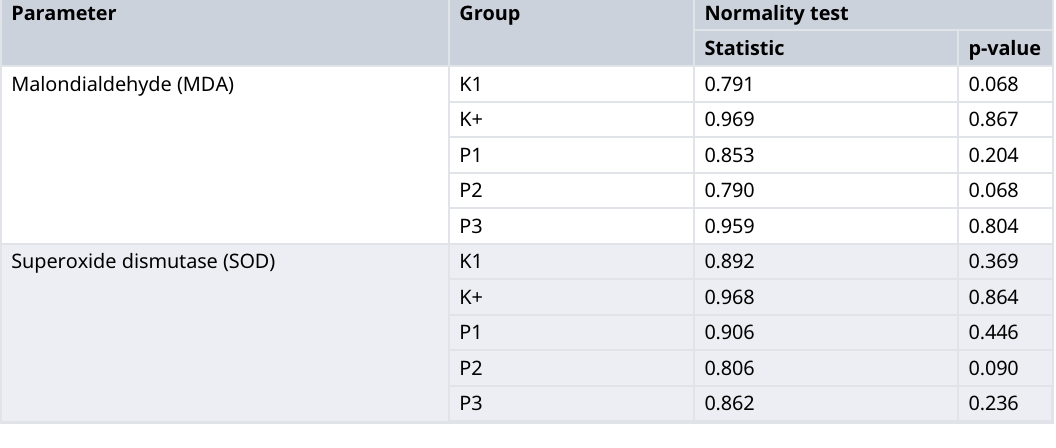
Table 1. Normality for test MDA and SOD, with Shapiro-Wilk test, p>0.05. Parameter